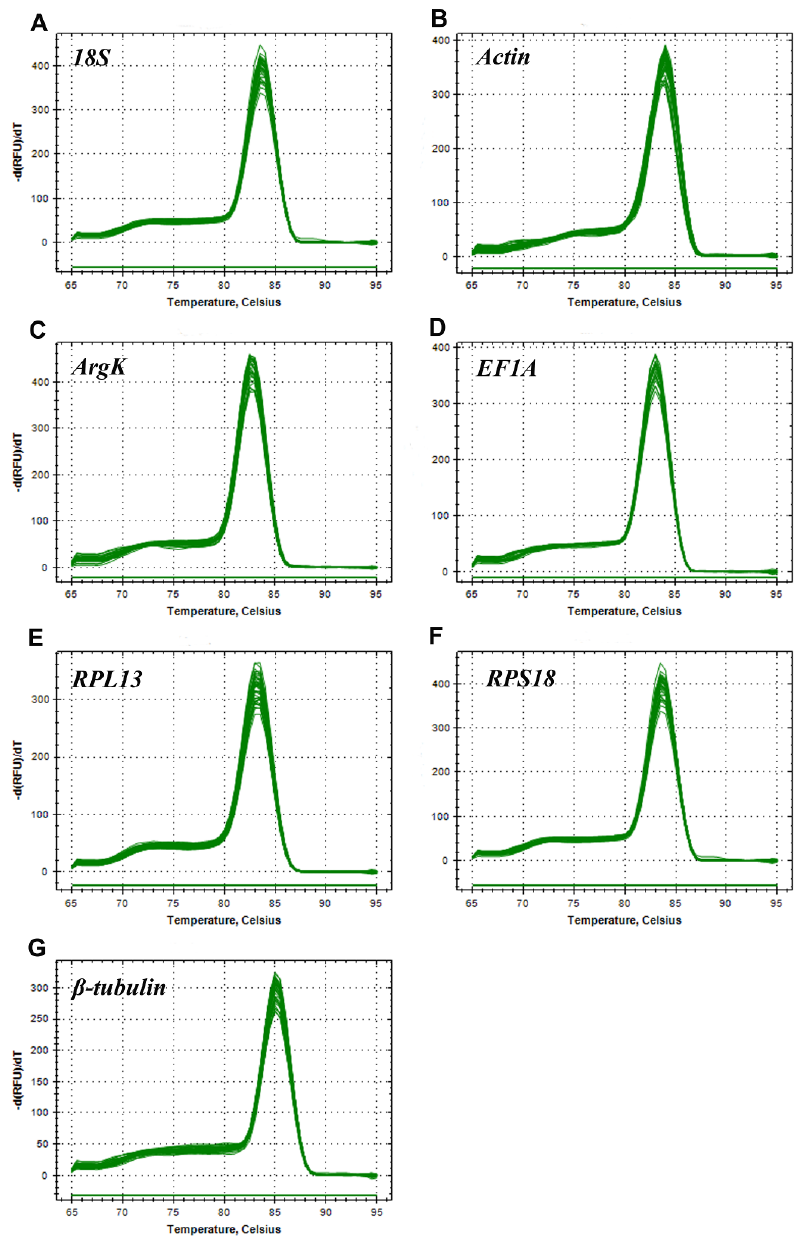
Figure 2. Melting curves of the seven candidate reference genes in Tamarixia radiata . ( A ) 18S , ( B ) Actin , ( C ) ArgK , ( D ) EF1A , ( E ) RPL13 , ( F ) RPS18 , and ( G ) β -tubulin